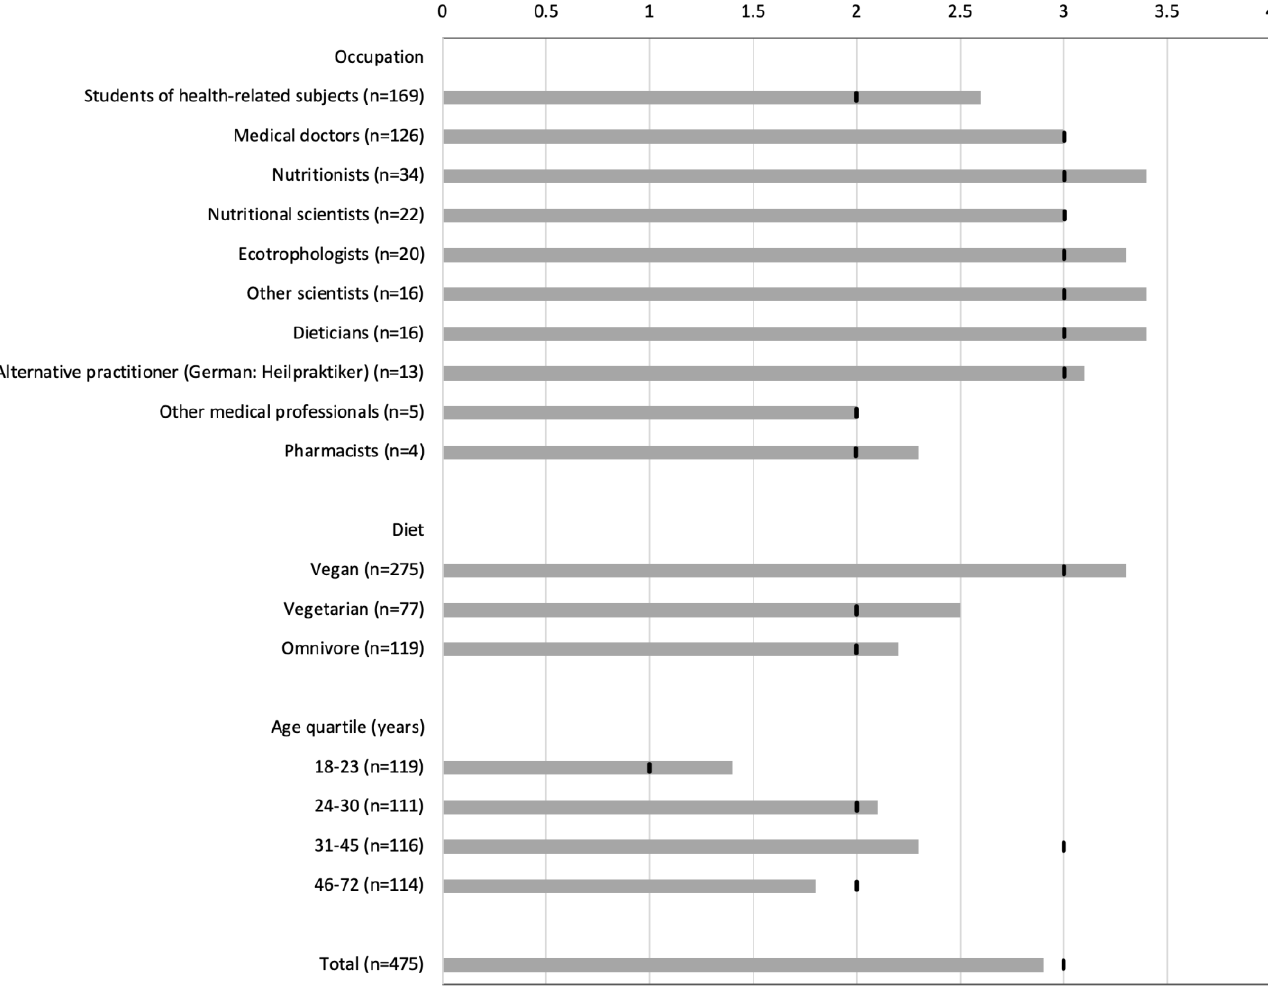
Figure 1. Score on knowledge of recommendations from nutrition societies (columns indicate mean values, vertical bars indicate median values).